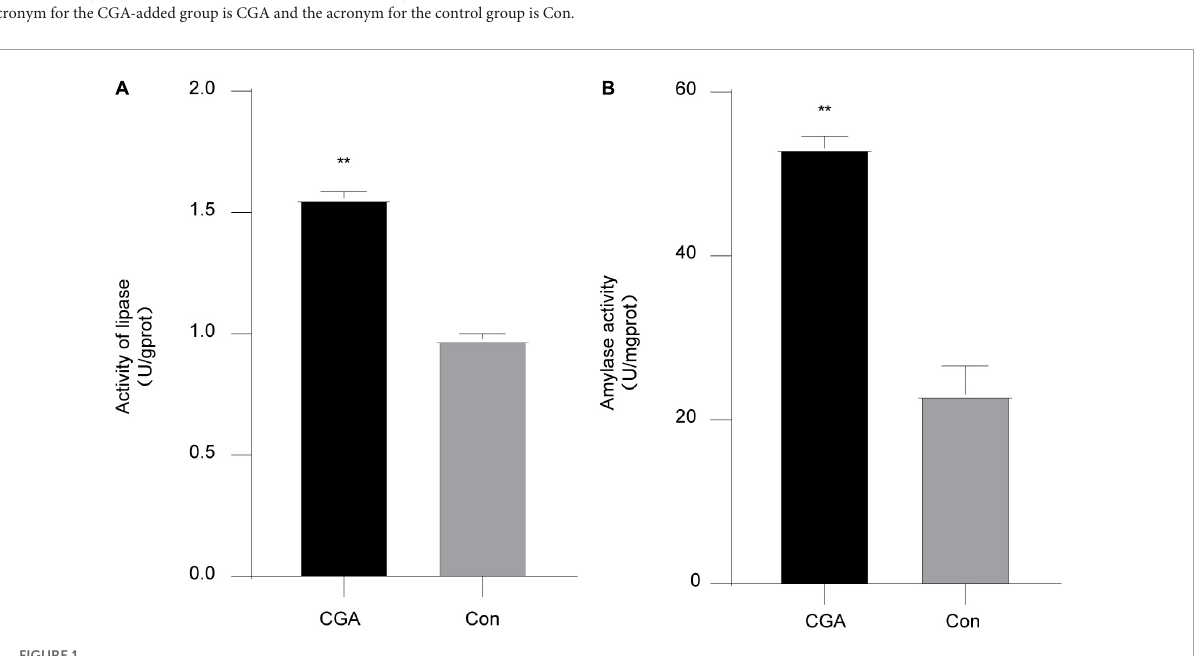
FIGURE1 Intestinal digestive enzyme activities. (A) Effect of chlorogenic acid (CGA) on intestinal lipase. (B) Effect of CGA on intestinal amylase. **Indicates a significant difference compared with the control group ( P < 0.01). The acronym for the CGA-added group is CGA and the acronym for the control group is